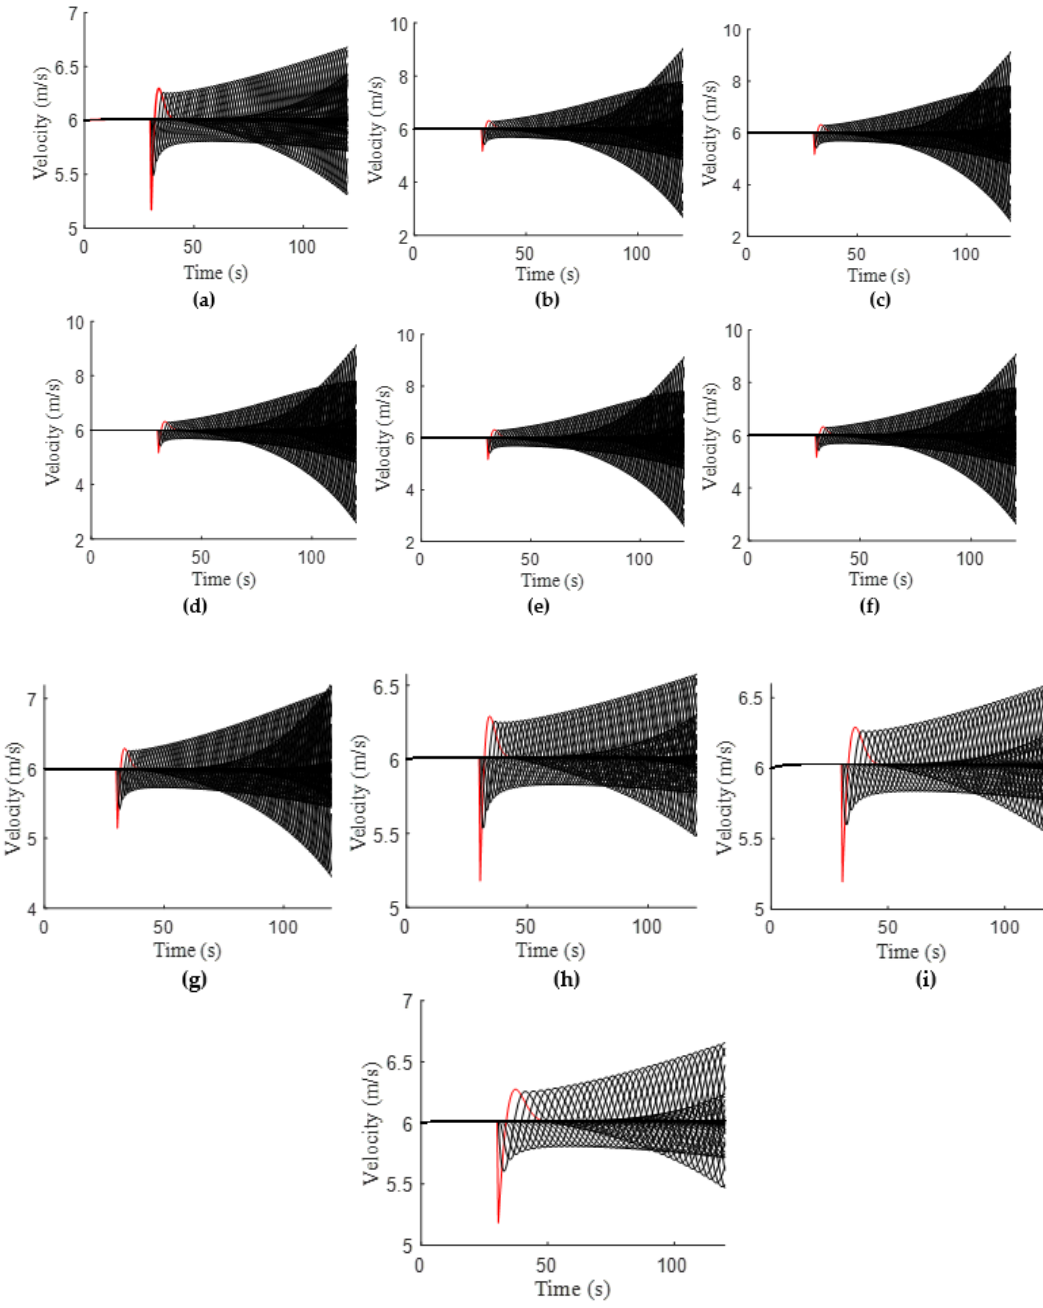
Figure 3. Velocity evolution of the ID and proposed models with an initial equilibrium velocity of 6 m/s: ( a ) δ = 1; ( b ) δ = 4; ( c ) δ = 10; ( d ) δ = 30; ( e ) a = 0.5 m; ( f ) a = 0.6 m; ( g ) a = 1